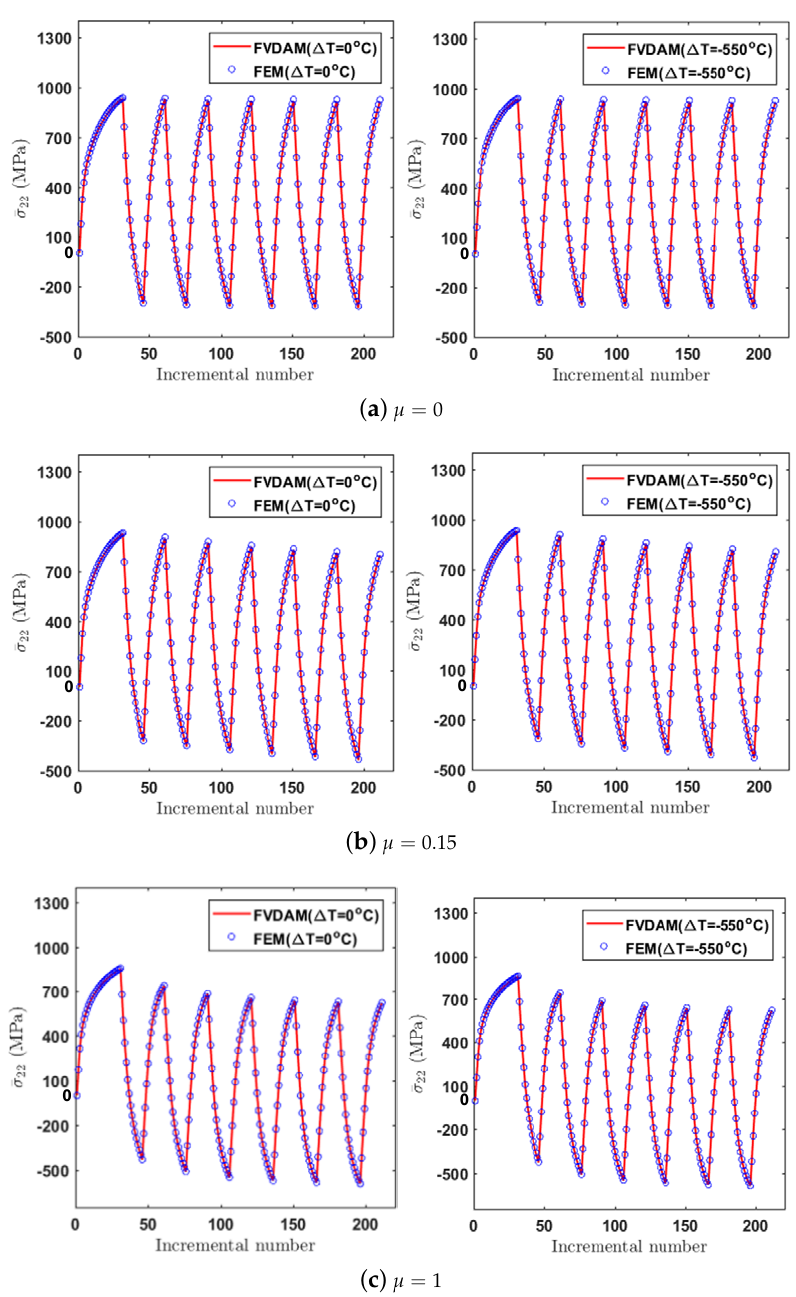
Figure 9. Comparison of the cyclic response of the unidirectional composite materials generated by FEM and